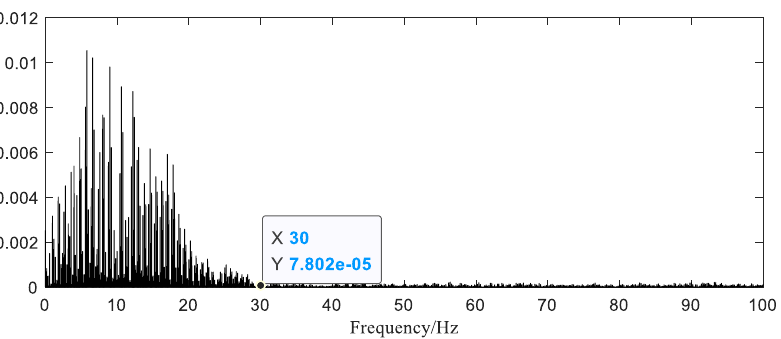
Figure 9. Ten cycle current signal.